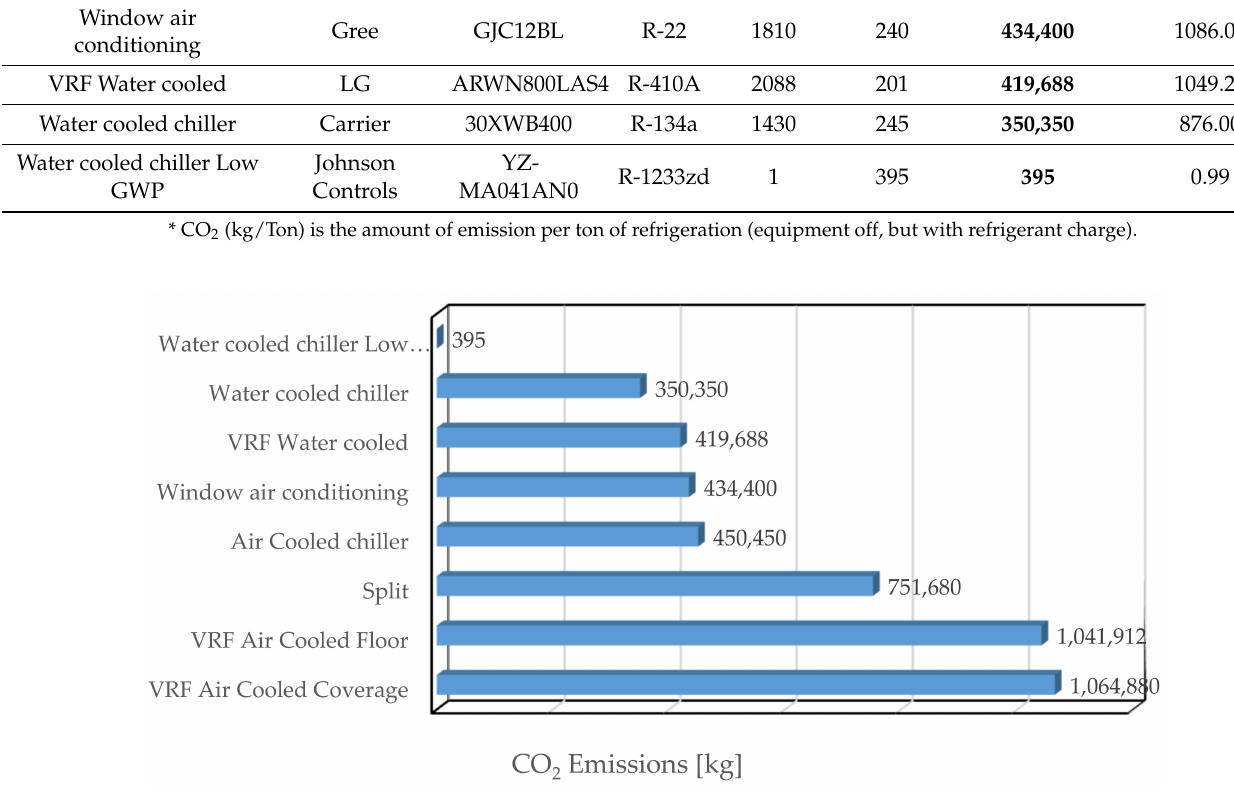
Figure 1. CO 2 emissions by type of